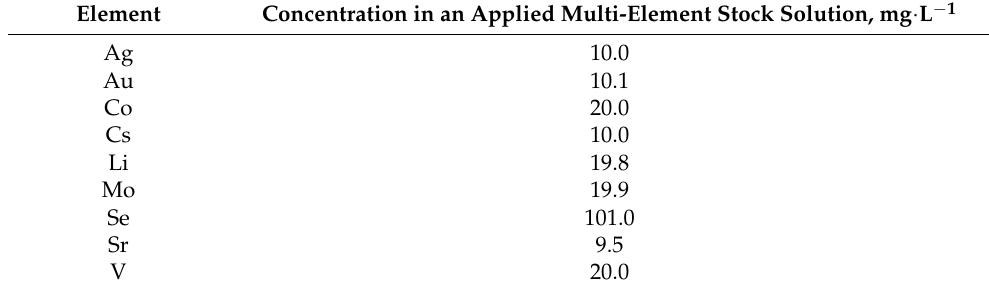
Table 2. The concentration of each analyzed element in an applied multi-element stock solution.